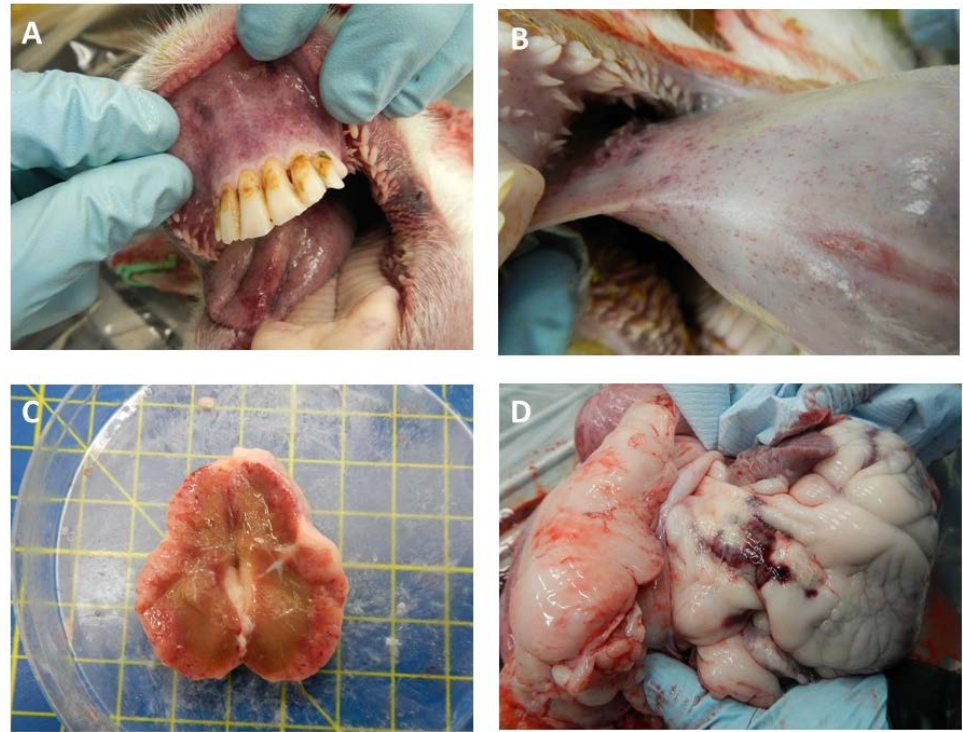
Figure 5. Hemorrhages observed across different organs in BTV co-infected sheep. BTV-specific pathological features observed in sheep 1 and 3 euthanized at day 7 post-infection included hemorrhages, petechial bleeding, and ulceration in the oral mucosa membrane ( A ), tongue ( B ), pre-scapular lymph node ( C ), and pulmonary artery ( D ).